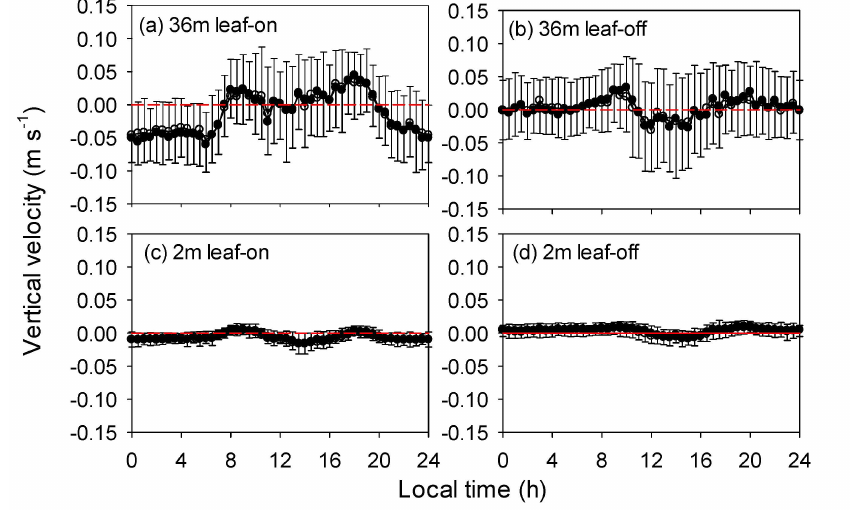
Figure 3. Diurnal courses of vertical wind velocity above (36 m) and below (2 m) the canopy during the leaf-on and leaf-off seasons of 2012. ( a ) 36 m for leaf-on season, ( b ) 36 m for leaf-off season, ( c ) 2 m for leaf-on season, and ( d ) 2 m for leaf-off season. Open circles are mean values, filled circles are the median and error bars indicate the range between the 25 and 75 percentile, respectively. The dashed lines are zero